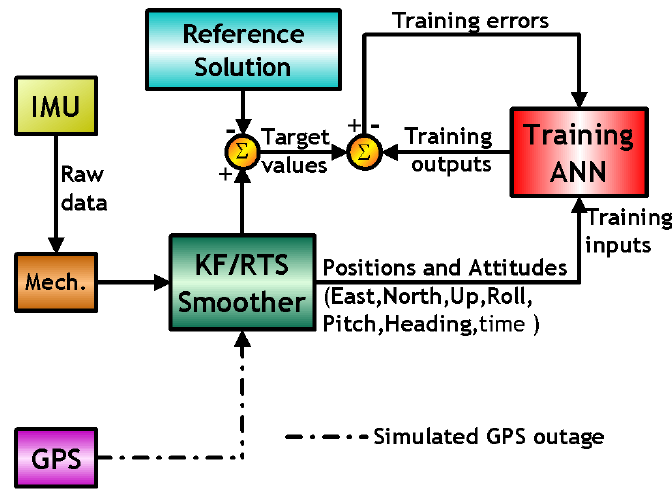
Figure 15. An ANN training architecture (adopted from